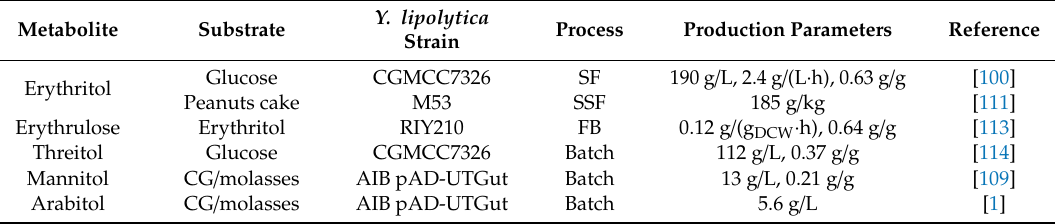
Table 2. Process parameters of the most promising sugar alcohol and derivatives produced by Y. lipolytica SF: shake-flask; SSF: solid state fermentation; RBC: repeated batch culture; is FBB: in situ fibrous bed bioreactor; FB: fed-batch; CG: crude